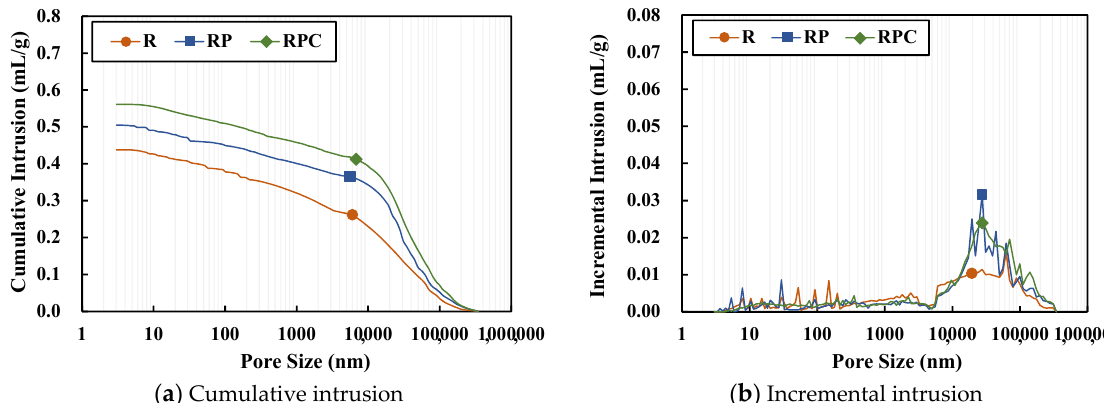
Figure 12. Mercury intrusion porosimetry outputs of the specimens of 7 days age.